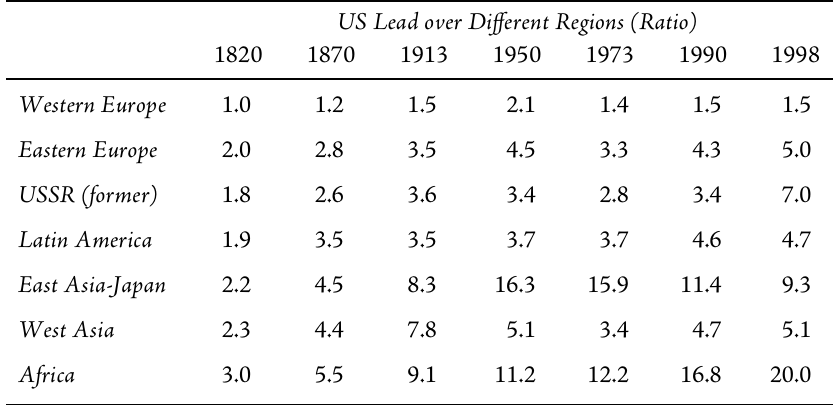
Table 2 – Global Disparities in PCI: Regional